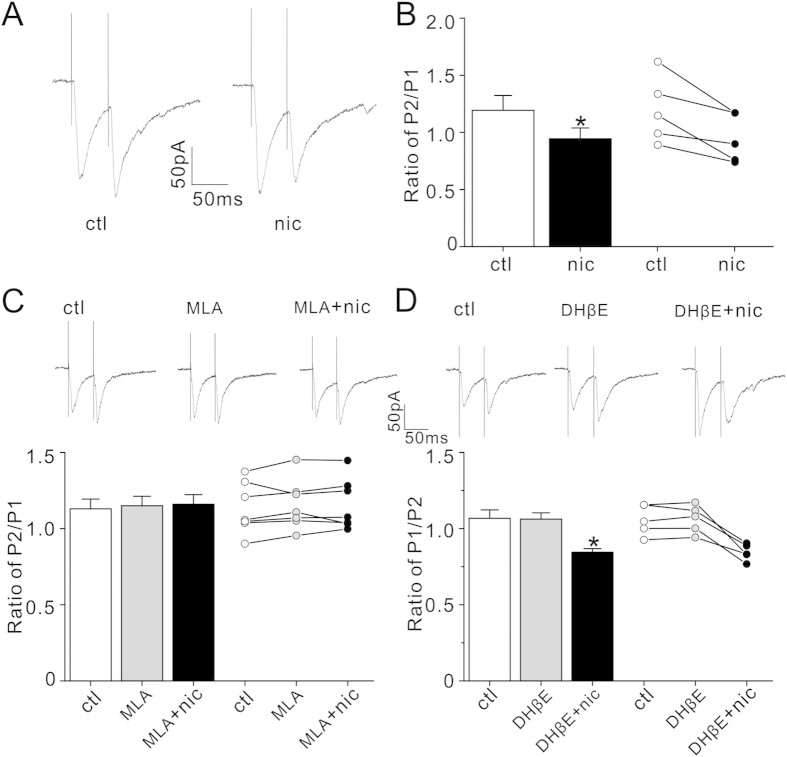
Paired-pulse inhibition by nicotine is blocked by α7-nAChR antagonist.(A) Representative traces resulting from paired-pulse stimulation at an interpulse interval of 50 ms in the absence (ctl) and presence nicotine (nic). (B) Histograms and dot plots showing nicotine treatment decreases the paired-pulse ratio (PPR, second peak over first peak, P2/P1). *p < 0.05 (nicotine vs. control in the same cells, paired Student’s t-test, n = 5). (C) Representative traces resulting from paired-pulse stimulation (top) with histograms and dot plots of PPR (bottom) before (ctl), after MLA alone (10nM) and MLA (10nM) with nicotine (5 μM) (P > 0.05 in all groups, two way ANOVA followed by Bonferroni’s LSD post hoc test, n = 7). (D) Representative traces resulting from paired-pulse stimulation (top) with histograms and dot plots of PPR (bottom) before (ctl), after DhβE alone (1 μM) and DhβE (1 μM) with nicotine (5 μM) (P = 0.90, ctl vs. DhβE; P = 0.03, ctl vs. DhβE +nic; *P = 0.04, DhβE vs. DhβE +nic, two way ANOVA followed by Bonferroni’s LSD post hoc test, n = 5).